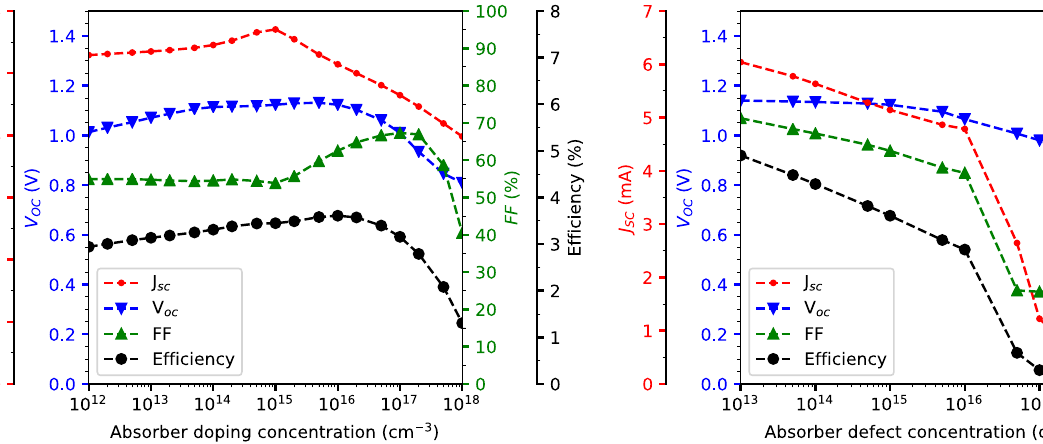
Fig. 6. Evolution of the solar cell performances with the defect concentration using typical physical parameters obtained by the spray pyrolysis process.